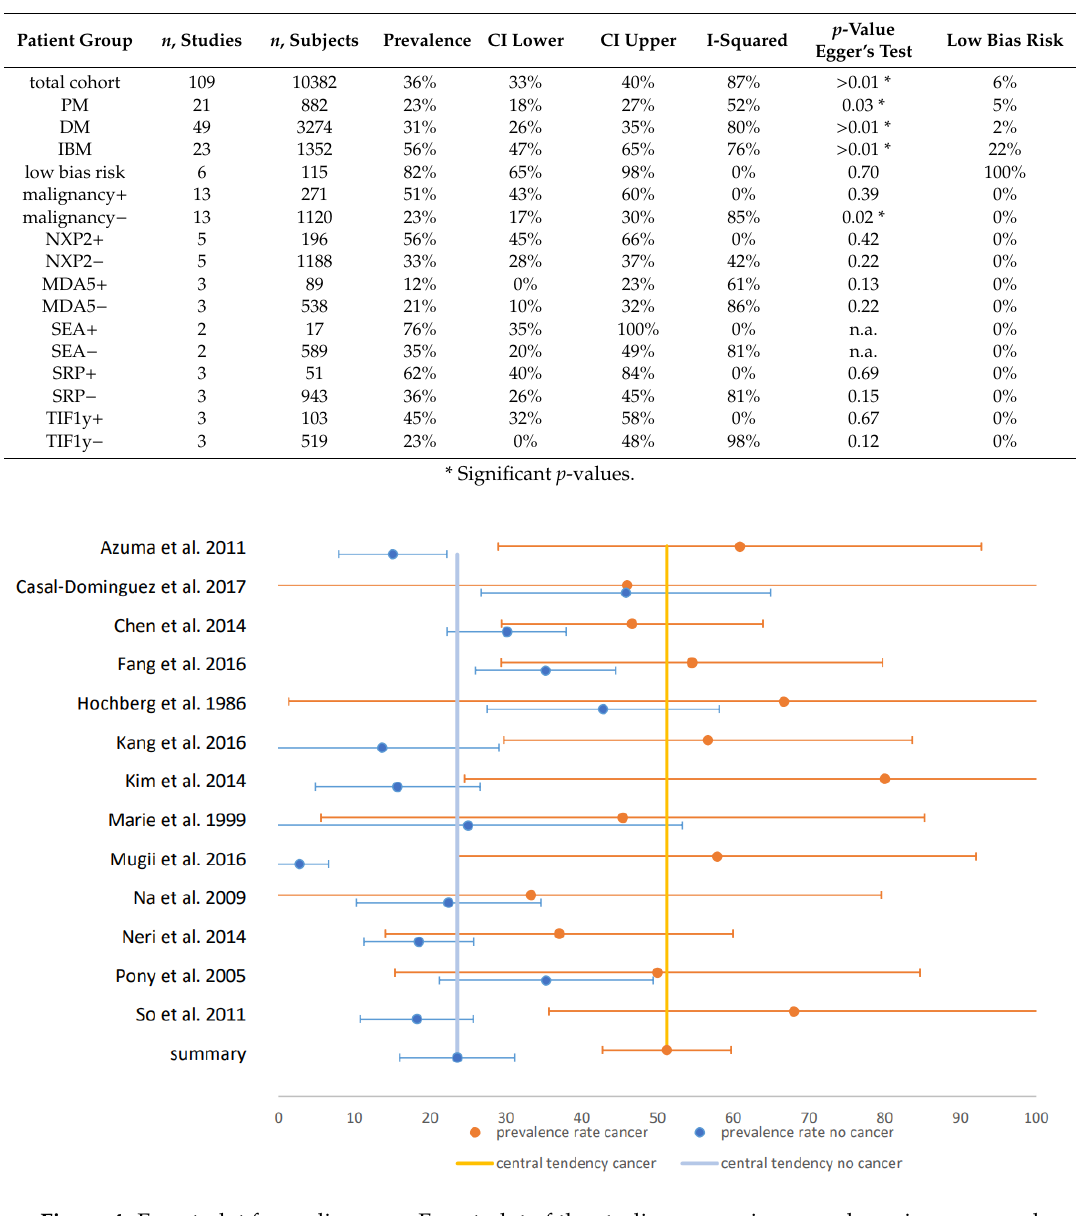
Figure 5. Forest plot for NXP2: Forest plot of the studies comparing prevalence in NXP2-positive and -negative IIM: x-axis shows the prevalence in %.